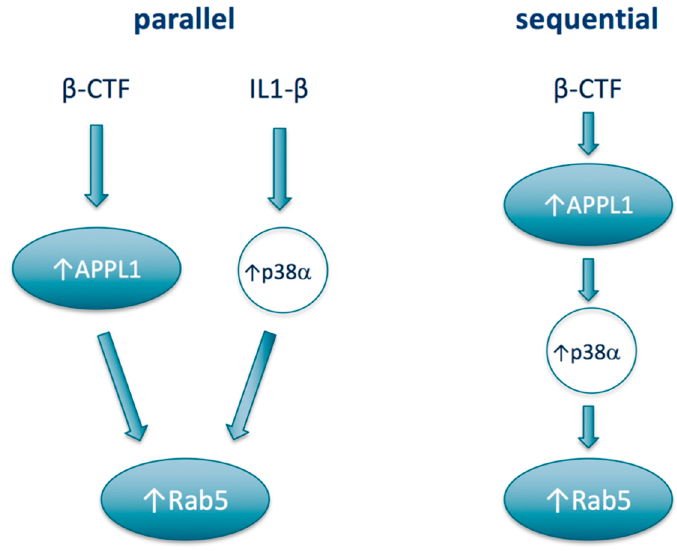
Figure 2. Potential models of relationships between APPL1, Rab5, and p38 α .